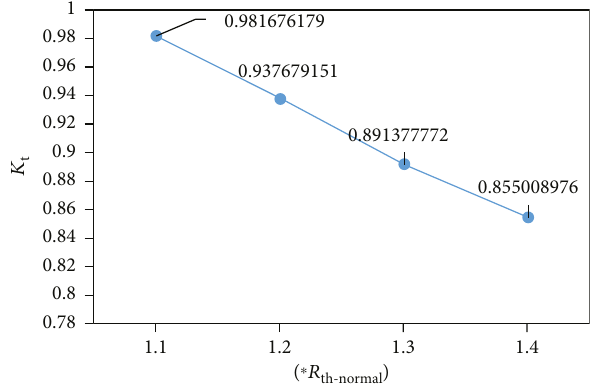
Figure 15: The coe ffi cient of junction temperature sharing between D 1 and D 2